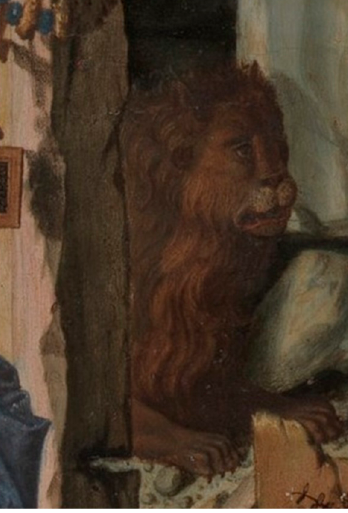
Figure 2. The lion. Vittore Carpaccio, Meditation . Detail.